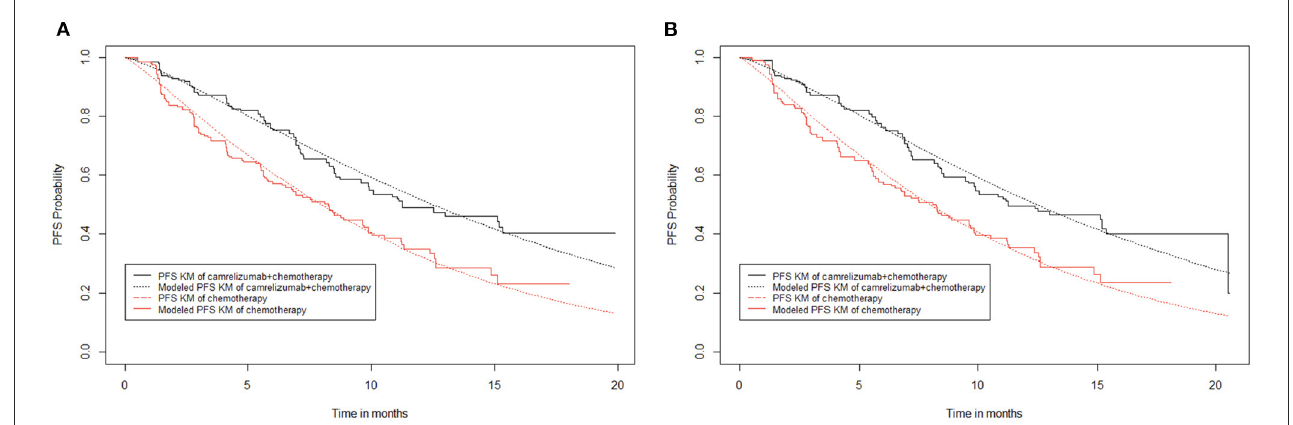
FIGURE2 Kaplan–Meier survival curves for progression-free survival. (A) Abandon extreme points. (B) Keep extreme points.